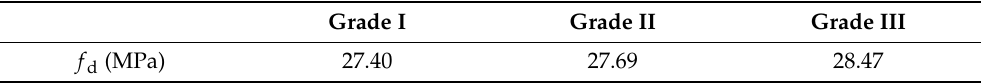
Table 4. Bending strength design values of P. edulis bamboo of different